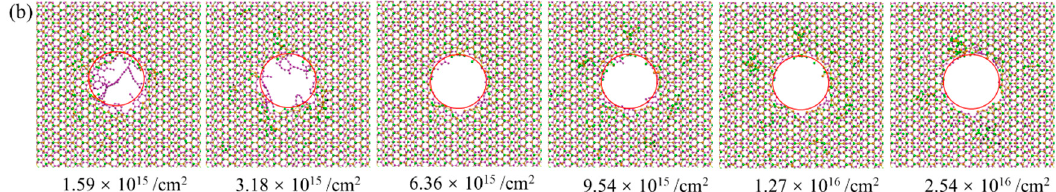
Figure 4. Configurations of the G/M heterostructure under ion irradiation with different ion energies and ion doses. ( a ) The influence of ion energy under a constant ion dose of 1.27 × 10 16 /cm 2 . ( b ) The influence of ion dose under a constant ion energy of 200 eV. The red colored circle is used to indicate the irradiation area.